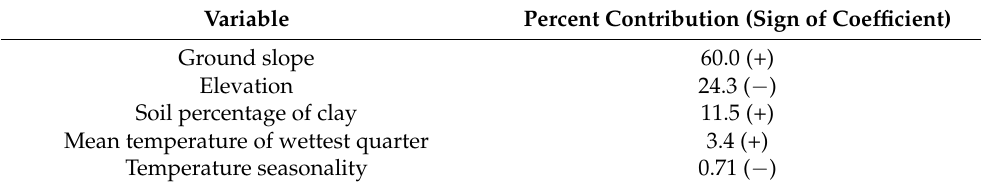
Table A3. Variable contribution and sign of coefficient for the Generalized Additive Model.